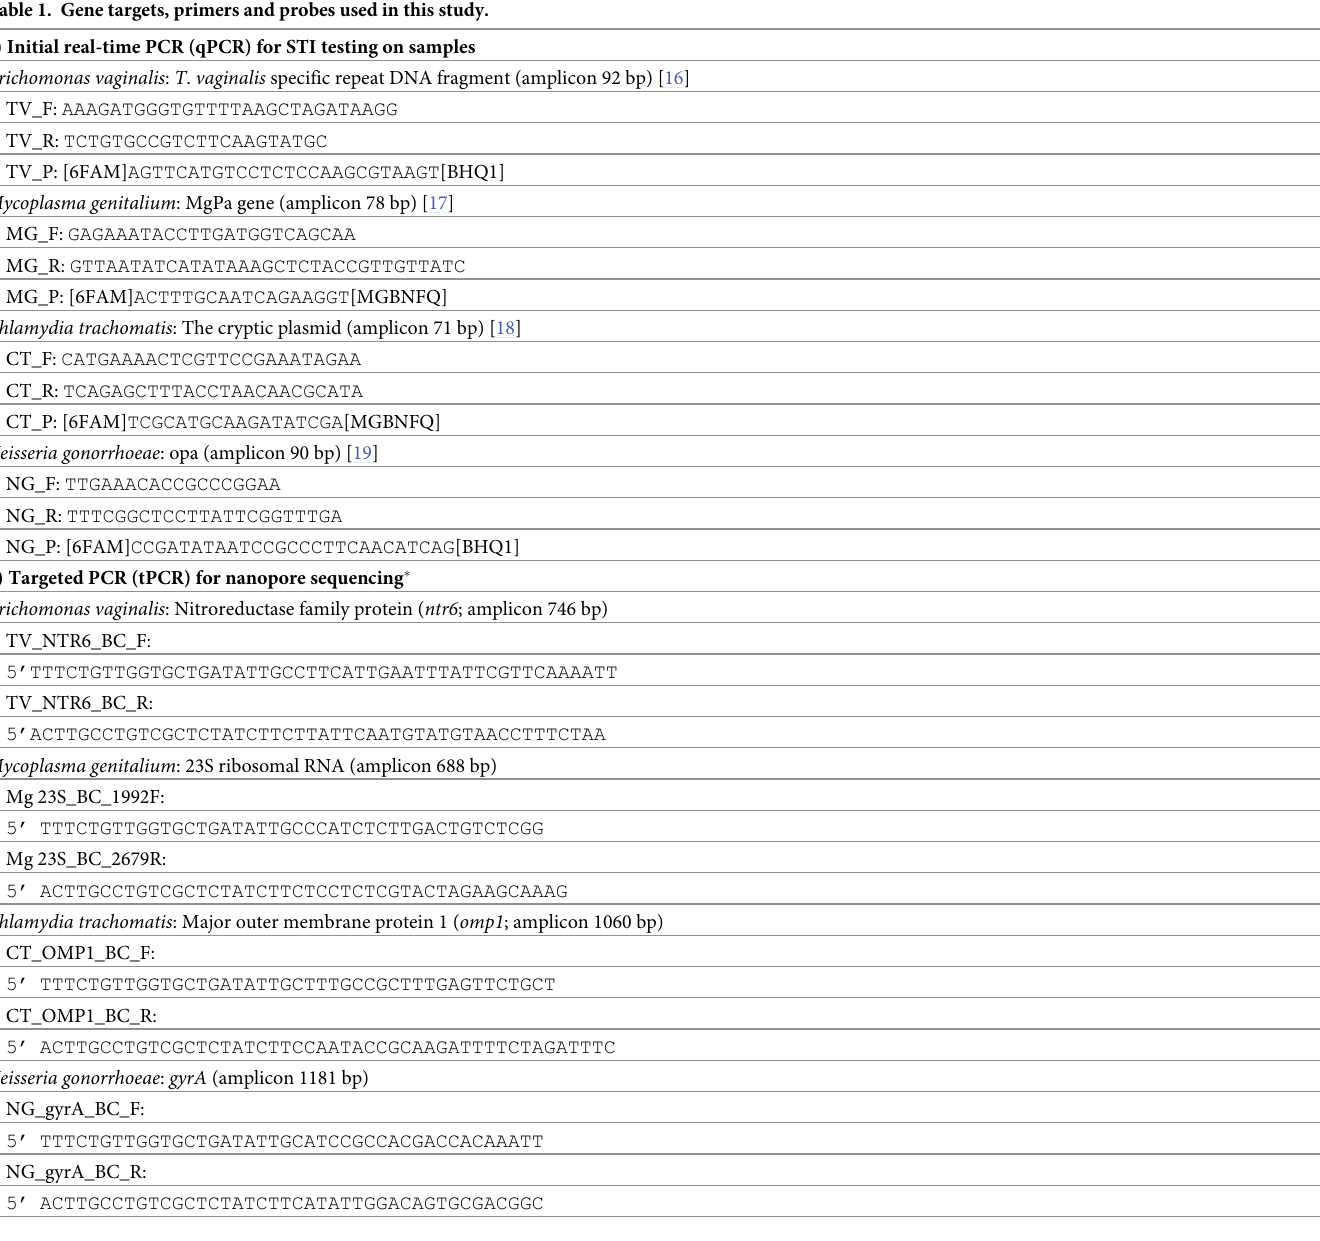
Table 1. Gene targets, primers and probes used in this